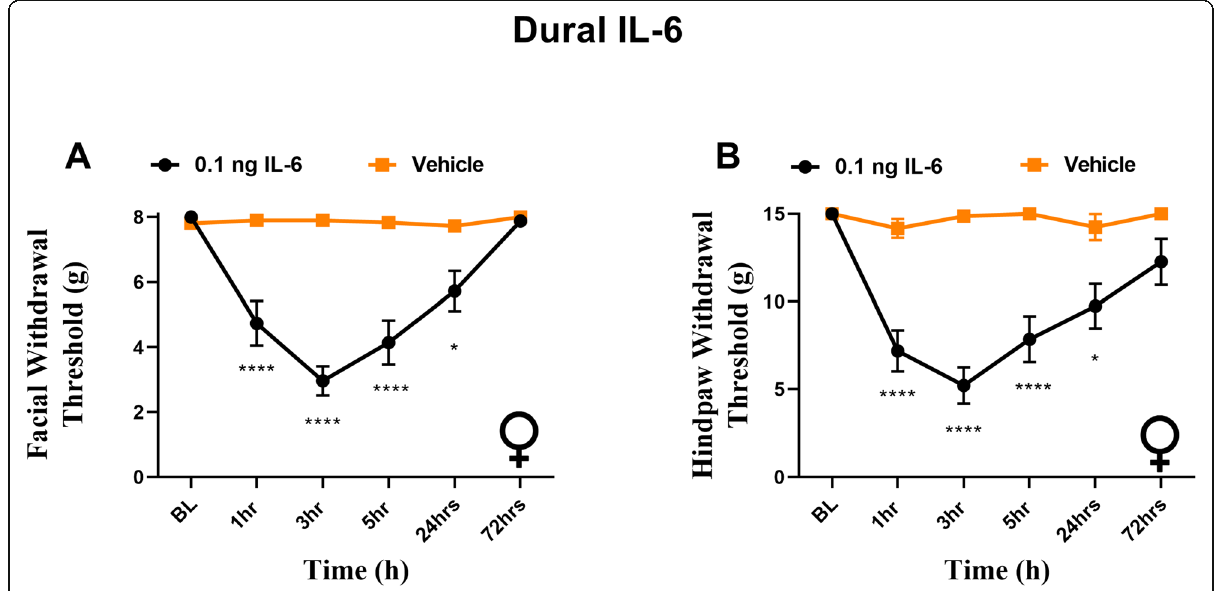
Fig. 1 Dural IL-6 produces facial and hindpaw hypersensitivity in females. Female rats had baseline withdrawal thresholds established prior to receiving administration of 0.1 ng IL-6 onto the dura. Dural IL-6 ( n = 10) elicited significant effect of treatment on facial ( A ) F (1, 66) = 31.58, p < 0.0001) and hindpaw ( B ) (F (1, 66) = 43.66, p < 0.0001) hypersensitivity when compared with animals that received vehicle ( n =